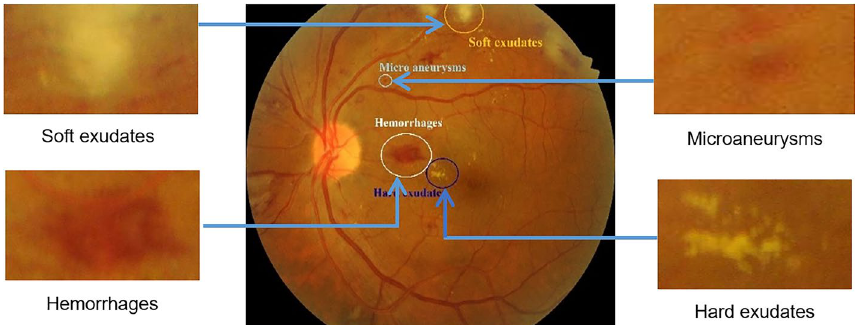
Fig. 2 A fundus image of the affected